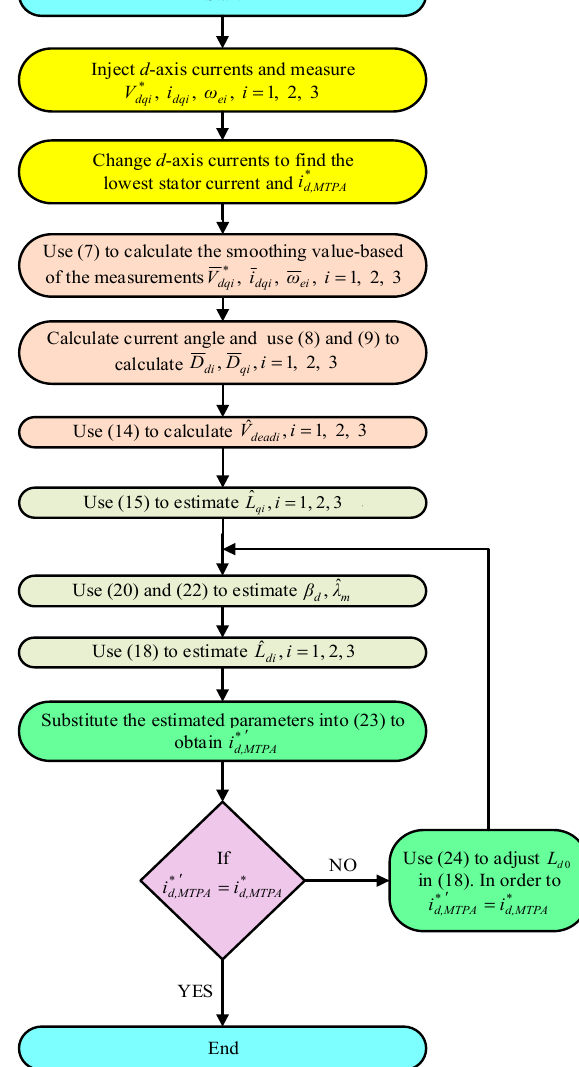
Figure 4. Flowchart of proposed estimation algorithm .